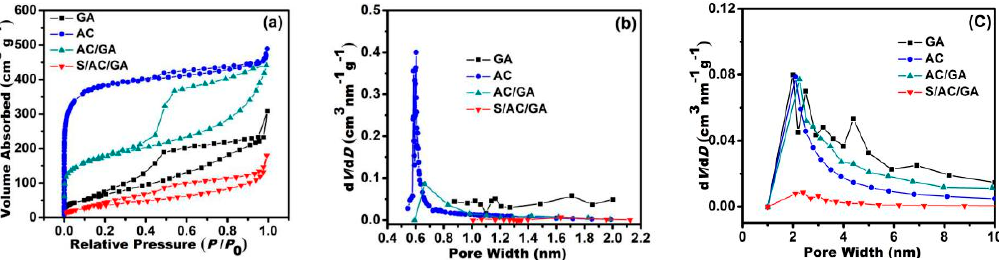
Figure 5. ( a ) N 2 adsorption/desorption isotherms, ( b , c ) Pore size distributions of GA, and AC, AC/GA, and S/AC/GA composites, respectively.